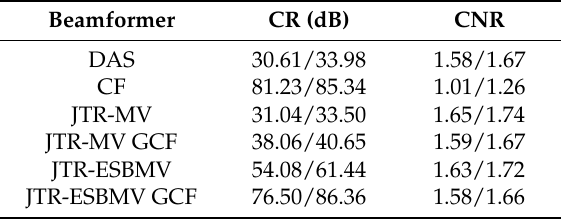
Figure 4. Simulated anechoic cysts using different beamformers: ( a ) DAS, ( b ) CF, ( c ) JTR-MV, ( d ) JTR- MV GCF, ( e ) JTR-ESBMV, ( f ) JTR-ESBMV GCF. All images are shown with a dynamic range of 60 dB. Table 3. CR and CNR for simulated anechoic cysts. Table 3. CR and CNR for simulated anechoic cysts.